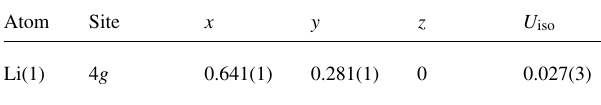
Table 2. Atomic coordinates and displacement parameters (in Å 2 ) .